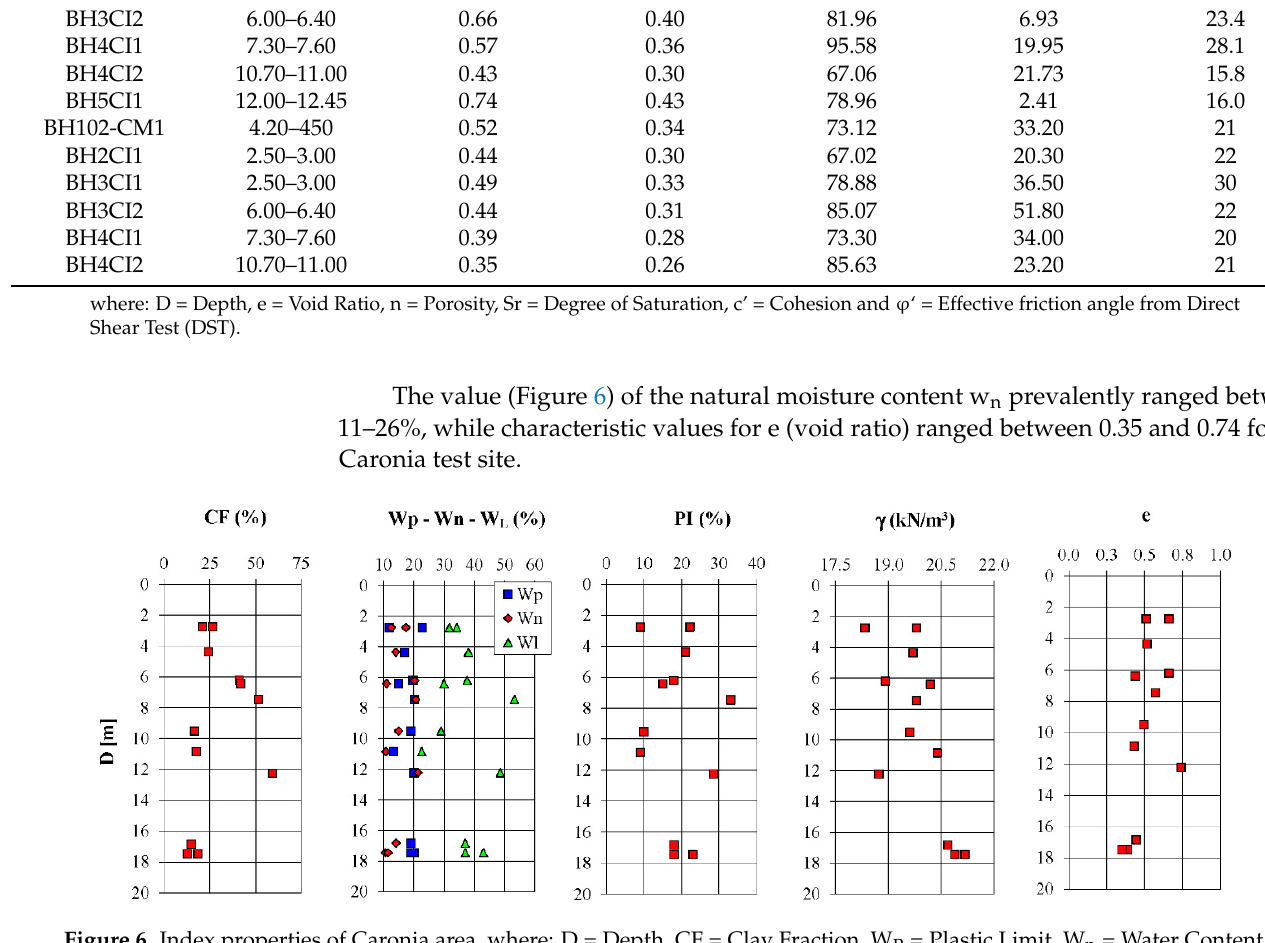
Table 3. Mechanical characteristics for Caronia area.